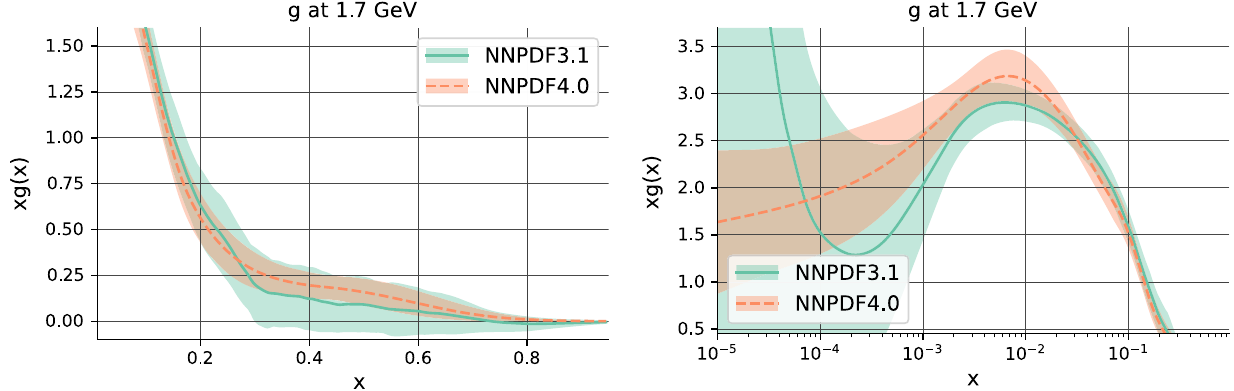
Fig. 2 The gluon PDF as determined with the NNPDF3.1 and NNPDF4.0 methodologies, on a linear (left) and logarithmic (right) scale in x